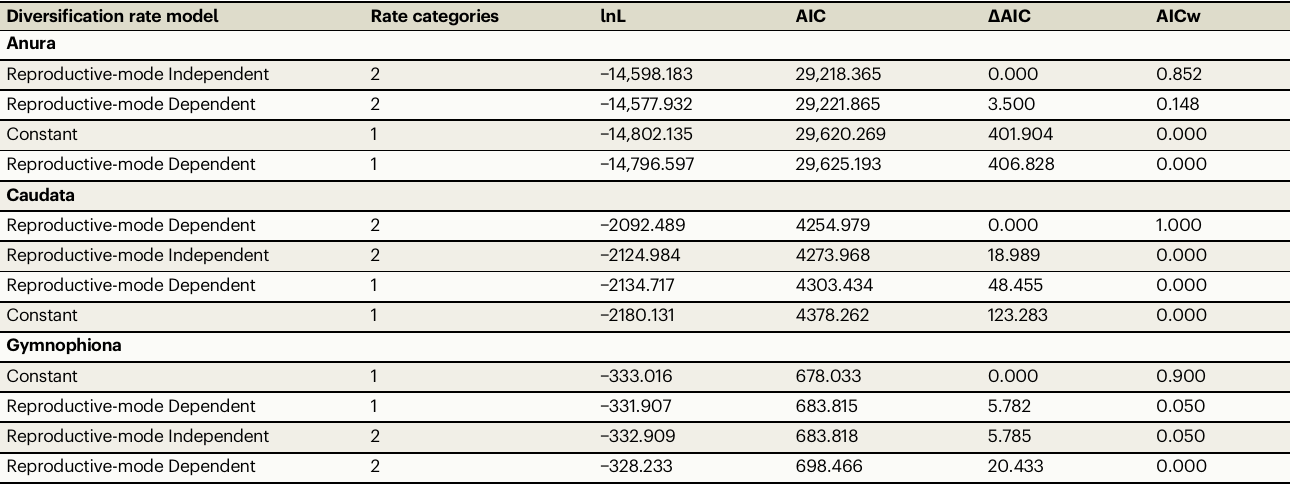
Table 2 | Ranking of model performance of state-dependent speciation and extinction “ secsse ” models for the three major groups of